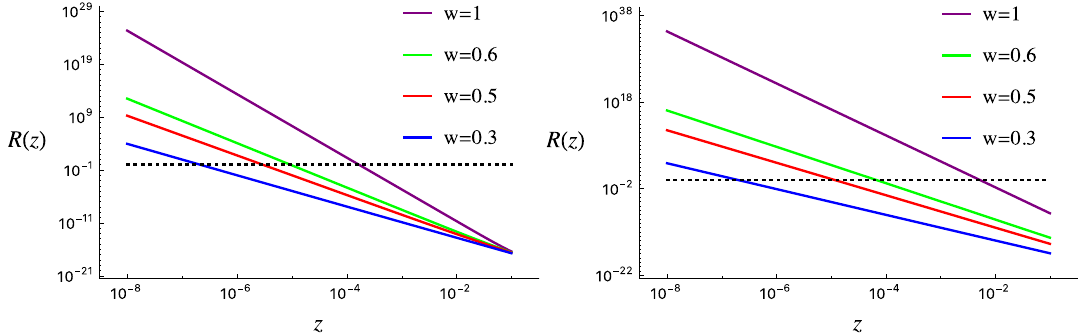
Figure 18 . This (cid:12)gure shows the ratio R ( z ) of the evolution term W ( z ) to the lepton number violating term W ( z ) in the Boltzmann equation for w = 0 : 3, 0 : 5, 0 : 6 and 1, with z (cid:3) = 0 : 1 (left-hand (cid:12)gure) and z (cid:3) = 100 (right-hand (cid:12)gure). Note the crossover point where R ( z ) = 1 (dotted line) is shifted to higher values of z as w is increased. The parameters are as in (cid:12)gure 17. expressions for N ( z ) in the di(cid:11)erent regions are derived for arbitrary w in appendix A. L At ultra-high temperatures the evolution term W ( z ) dominates in the Boltzmann equation and gives the universal behaviour N ( z ) (cid:24) 1 =z 2 for all w . Beyond the crossover point L